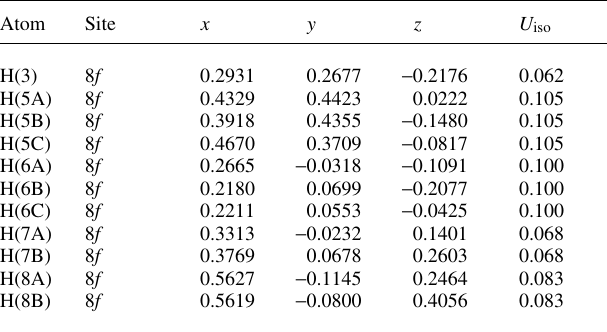
Table 2. Atomic coordinates and displacement parameters (in Å 2 ) .